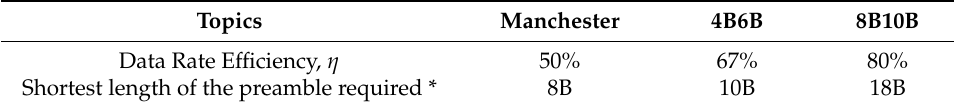
Table 4. RLL Codes and Data Rate Efficiency.